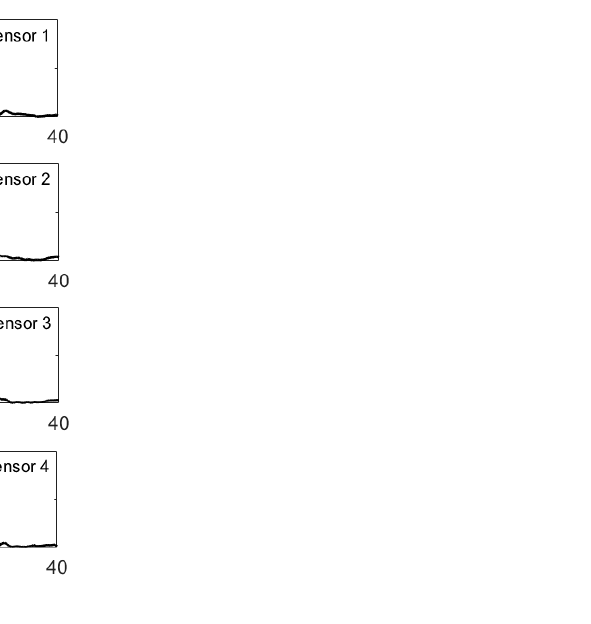
Figure 16. Frequency spectra, edge 15 cm from impactor; expected frequency marked with dashed line. Table 6. Integral and RMS of frequency spectrum, edge below impactor.